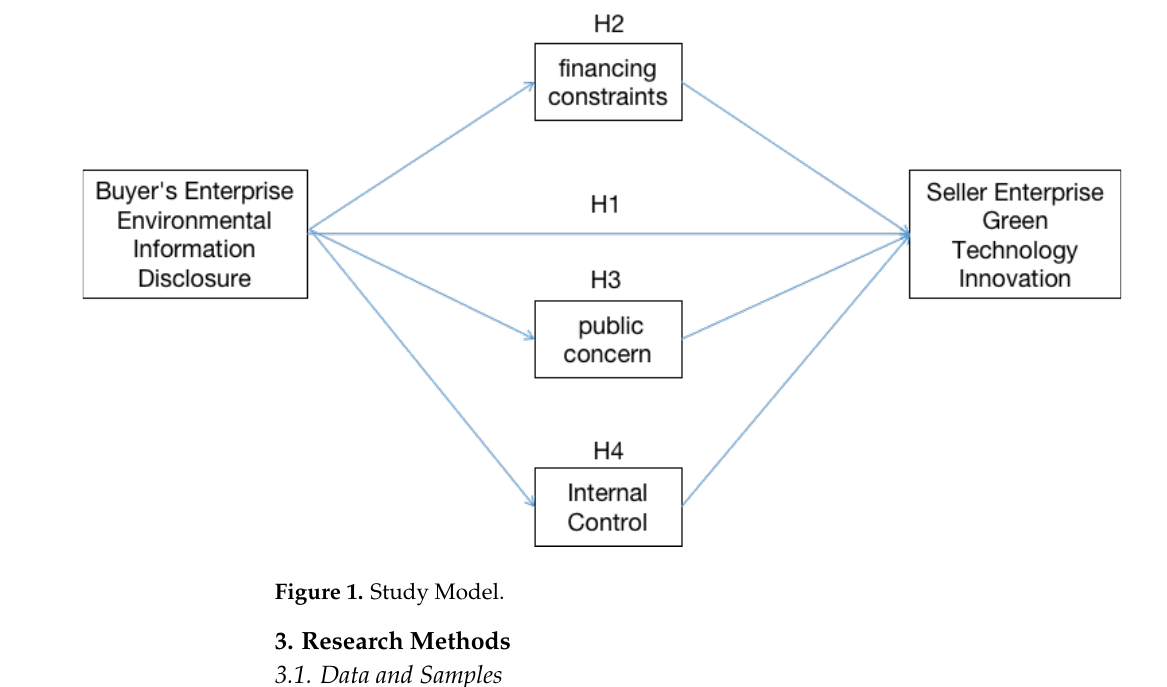
Figure 1. Study Model.